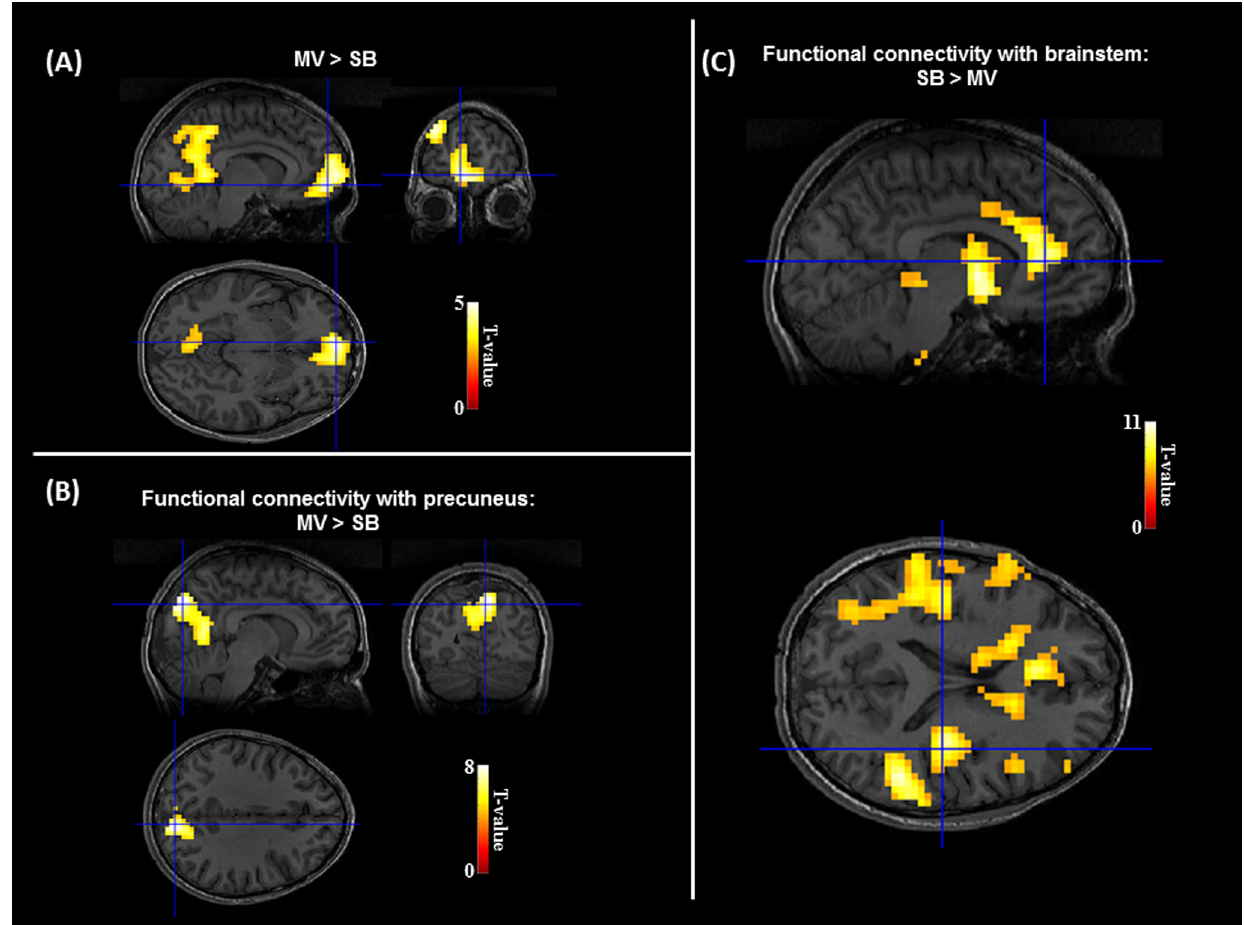
Figure 2. Restoration of DMN under mechanical ventilation. (A). Comparison of BOLD signal between MV and SB revealed a specific increase of activation in the default-mode network associated in awake controls in introspection and self-consciousness. No significant result was observed in the opposite contrast. See Table 1 for detailed fMRI results. (B&C). Functional connectivity assessed with a hypothesis-driven approach revealed a larger correlation with precuneus activity in posterior mesial areas during MV than during SB (B), and a larger correlation between brainstem activity and a large anterior cortico-subcortical network during SB than during MV (C). This large network resembles the executive attention network.